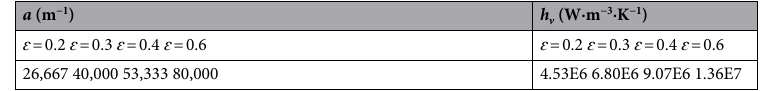
Table 5. Volumetric transfer areas and volumetric heat transfer coefficients considered in LTNE. a : volumetric transfer area; h v : volumetric heat transfer